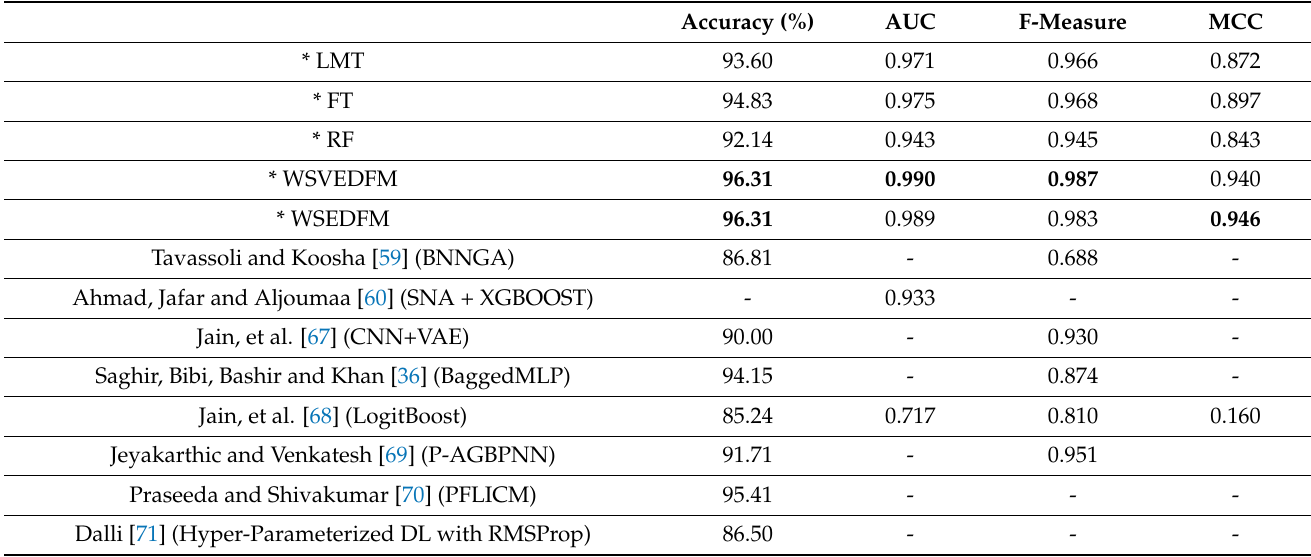
Table 15. The CCP performance of proposed DF methods and existing models on Dataset 1.